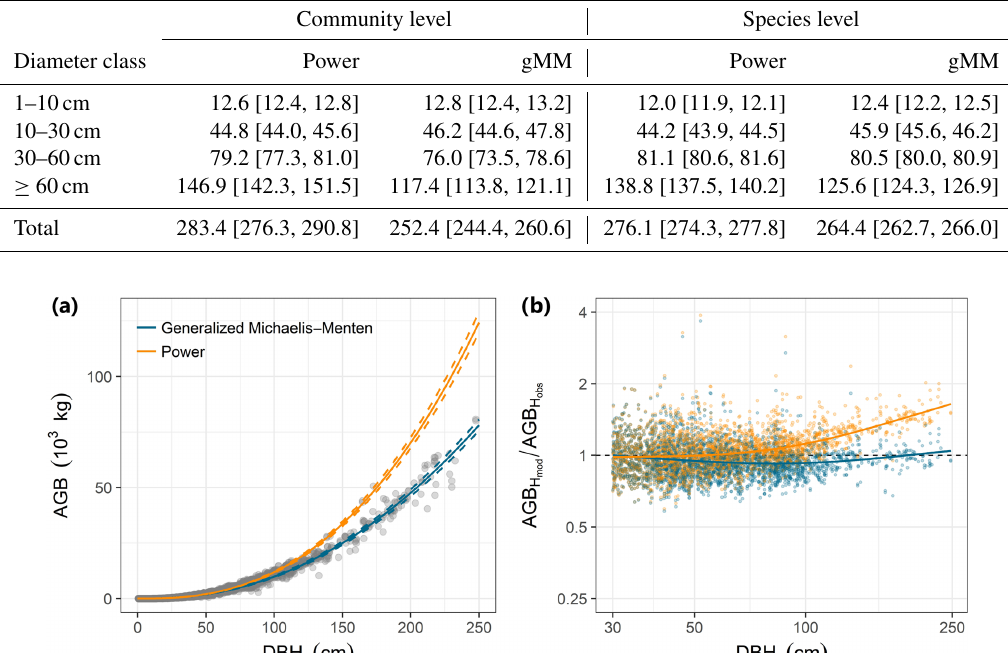
Table 3. Posterior mean estimates (with their 90% credible intervals) of total aboveground biomass density (Mgdrymassha − 1 ) in the 50ha plot on Barro Colorado Island (BCI) under alternative tree height scaling relationships. To estimate AGB, the height of each tree in the plot was predicted based on community- or species-level allometric models for the generalized Michaelis–Menten and power functions, together with the height-based biomass allometry equation from Chave et al. (2014); see methods for further details.